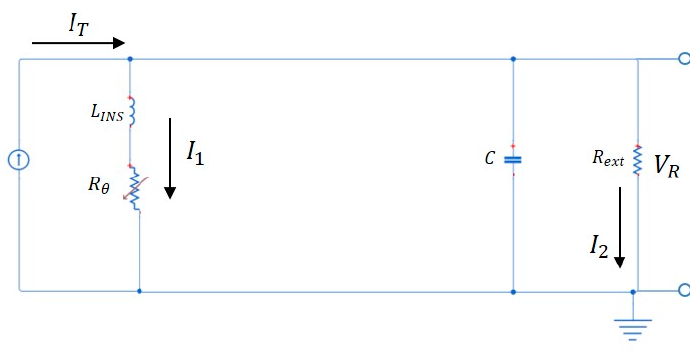
Figure 3. Equivalent circuit to explain the quench detection method.